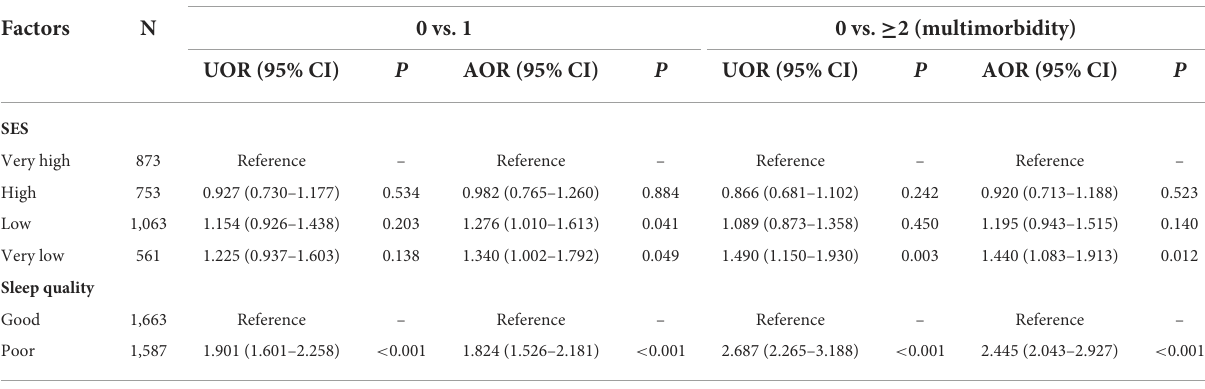
TABLE 3 Association of SES and sleep quality with multimorbidity in older adults.